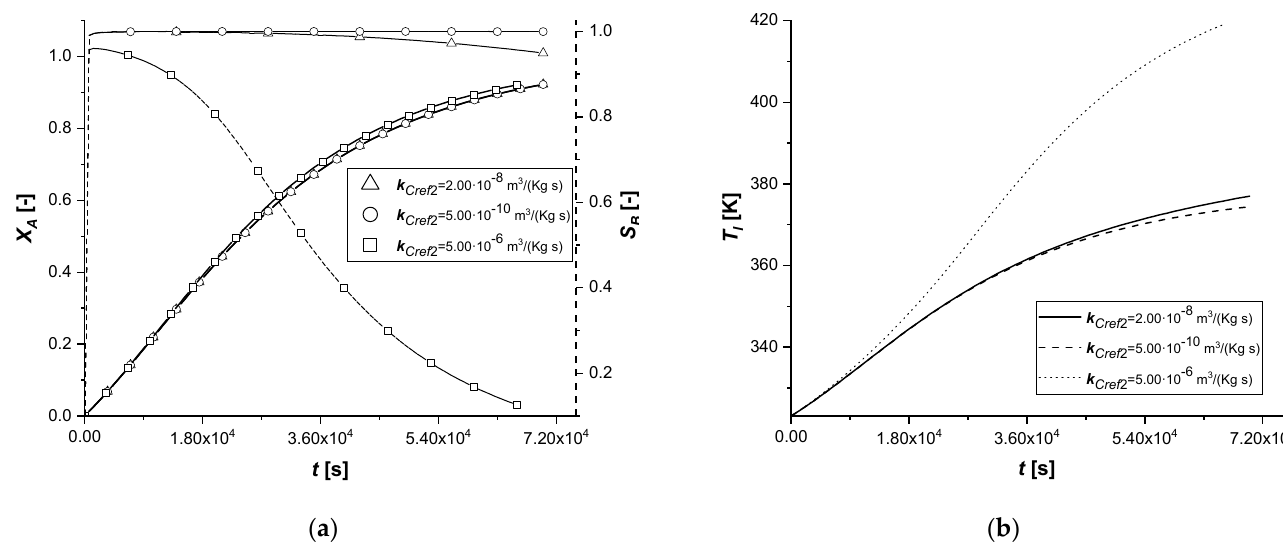
Figure 15. EW k Cref 2 investigation. ( a ) Bulk profiles over time of X A and S B . ( b ) Bulk profile of T l over time.